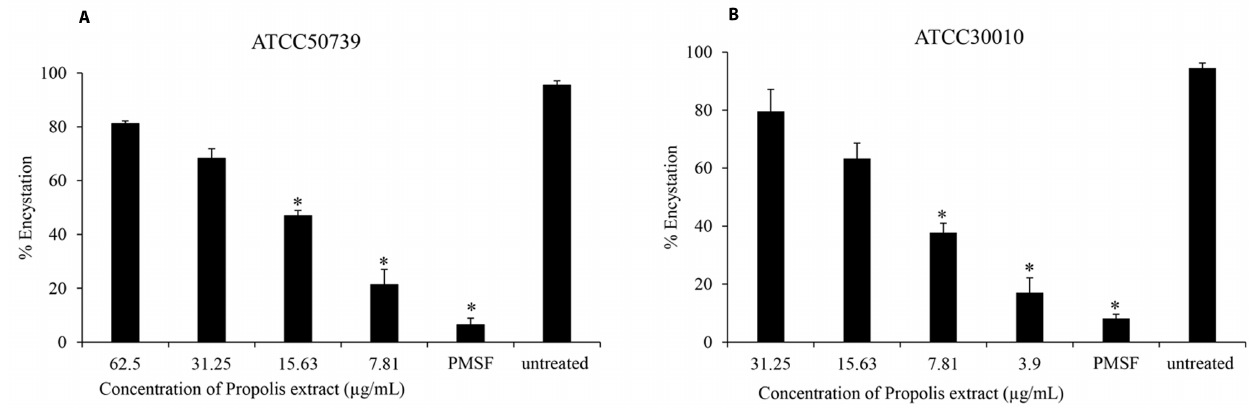
Figure 1. The effect of Propolis extract on encystation. The Propolis extract reduced the encystation in a dose-dependent manner on ( A ) A. castellanii ATCC50739 and ( B ) A. castellanii ATCC30010. The experiments were repeated three times, and the average values are presented with error bars representing standard deviations. *; significantly different at a P value of <0.05 by Student’s t test. PMSF, phenylmethylsulfonyl fluoride; ATCC, American Type Culture Collection.